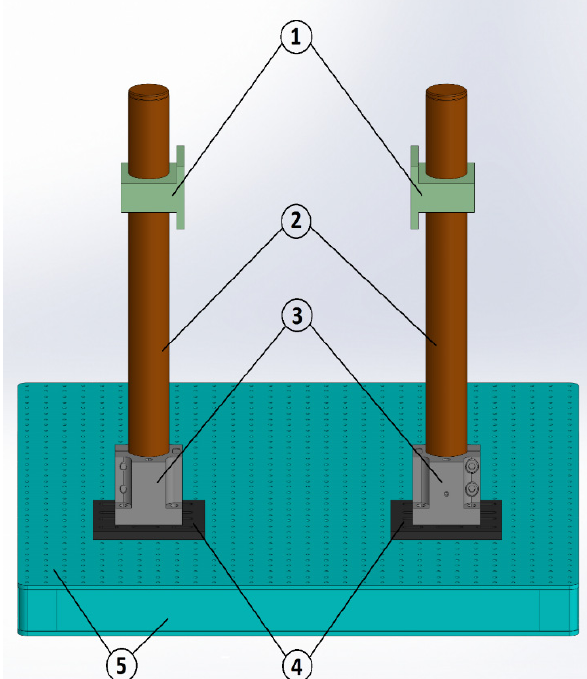
Figure 7. Adjustable system for MMI4D positioning. Legend: 1—reference for adjusting the position of the MMI4D on the Z axis; 2—cylinders for supporting MMI4D; 3—reference for fixing the MMI4D on the cylinders; 4—plate for mounting the adjustment system on the anti-vibration table; 5—anti- vibration table.